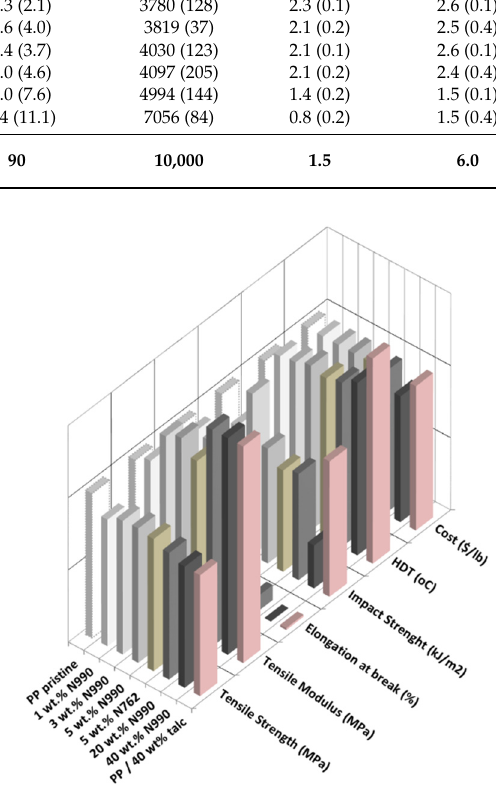
Figure 5. Comparison of tensile properties, impact properties, HDT, and materials costs of PP / TB N990 composites from this work and the PP / 40 wt. % talc, a commercial automotive